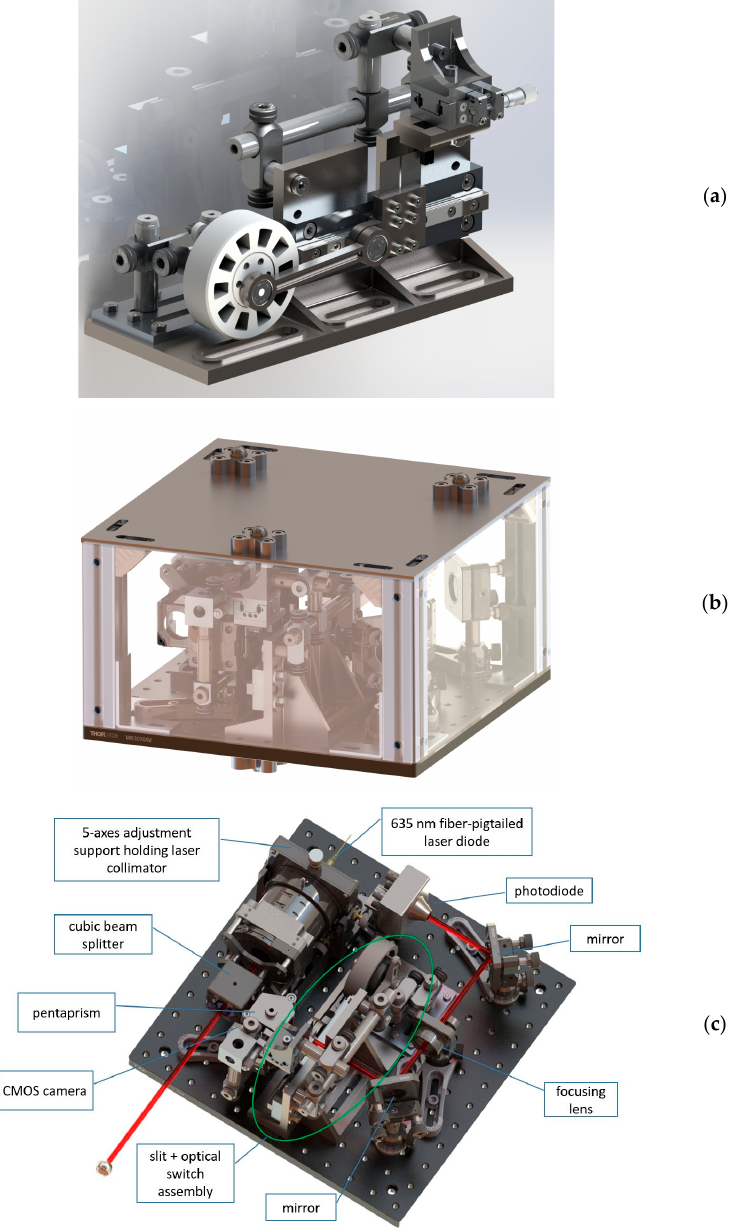
Figure 11. Details of the P3 design. The slider holds the oscillating slit and the digital optical switch ( a ). The overall device is enclosed with acrylic glass panels. Kinematic mounts are available on the top and bottom surfaces to enable reversal if required ( b ). Interior mounted on a breadboard ( c ). P3 was tested more thoroughly than P1 and P2. As with any other straightness measuring instrument, P3 compared a measured profile with a reference line. The P3 ′ s reference line was the light of the illuminating and retroreflected beams. Physics ensures